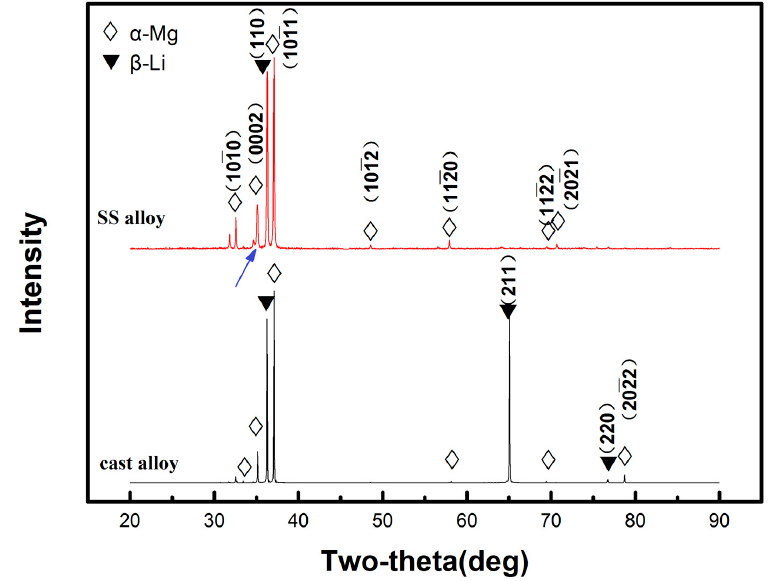
Figure 3. XRD patterns of the cast and SS Mg-9Li alloys.